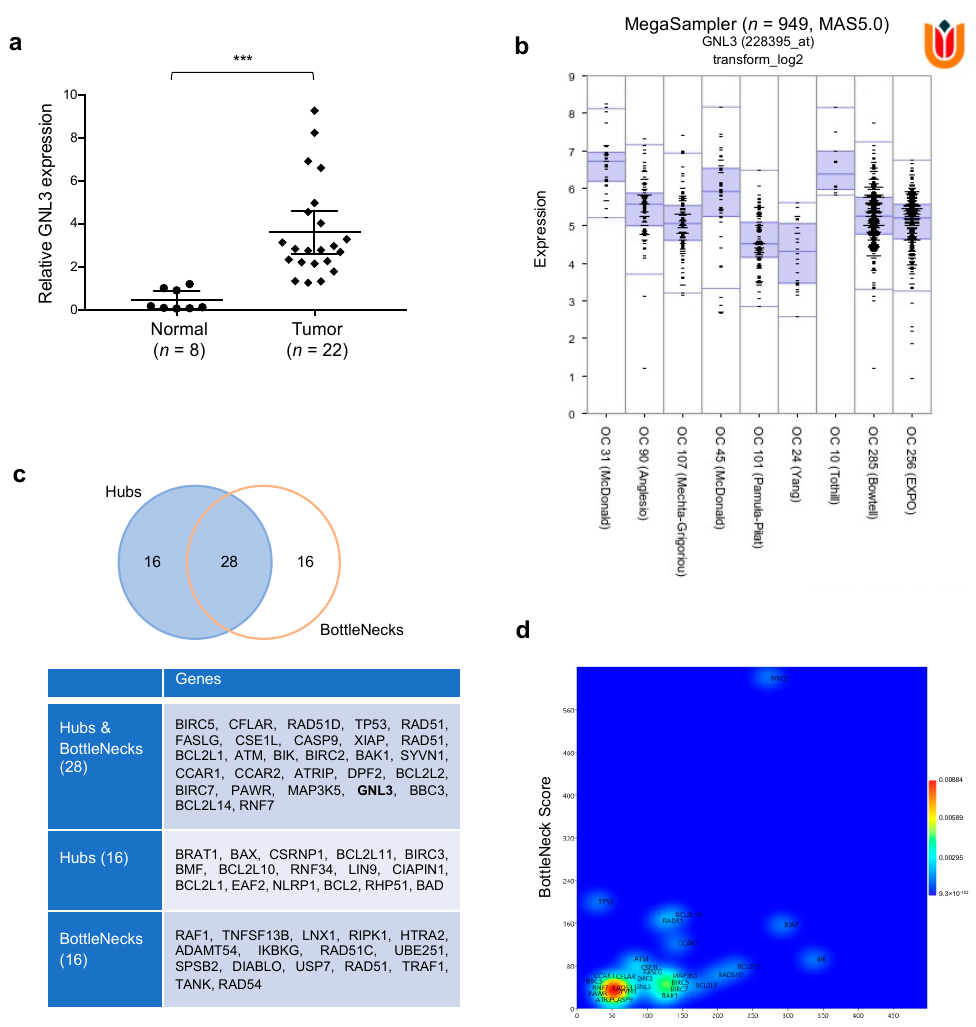
Figure 7. Biological significance of GNL3 expression in OC tumorigenesis. ( a ) GNL3 mRNA expression was assessed in 22 OC tumor biopsies and 8 non-tumoral ovarian tissues by q-PCR assays (*** p < 0.001). ( b ) Using ‘R2: Genomics Analysis and Visualization Platform (http://r2.amc.nl (accessed on 20 December 2020)), the expression of GNL3 gene was assessed in 9 different databases referred to different Ovarian Cancers, and it results always overexpressed, n = 949, p = 2.2 × 10 − 43 ( c ) The nodes acting as controller within the network are identified and classified as Hubs and BottleNecks, Hubs, or BottleNecks depending on their node degree and BottleNeck score. ( d ) A 2D Kernel Density Estimation (2D-KDE), Gaussian model, was carried out on Hubs and BottleNecks based on their node degree ( x -axis) and BottleNecks score ( y